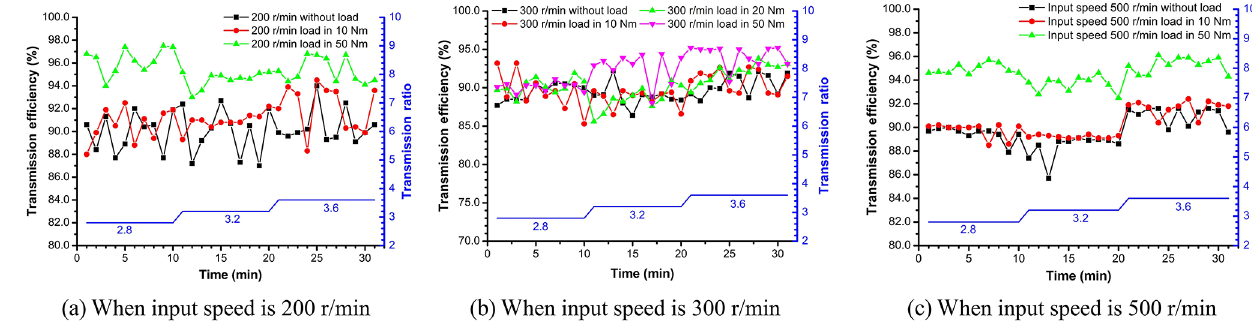
Figure 4. Transmission efficiency of different decelerating process with various loading.